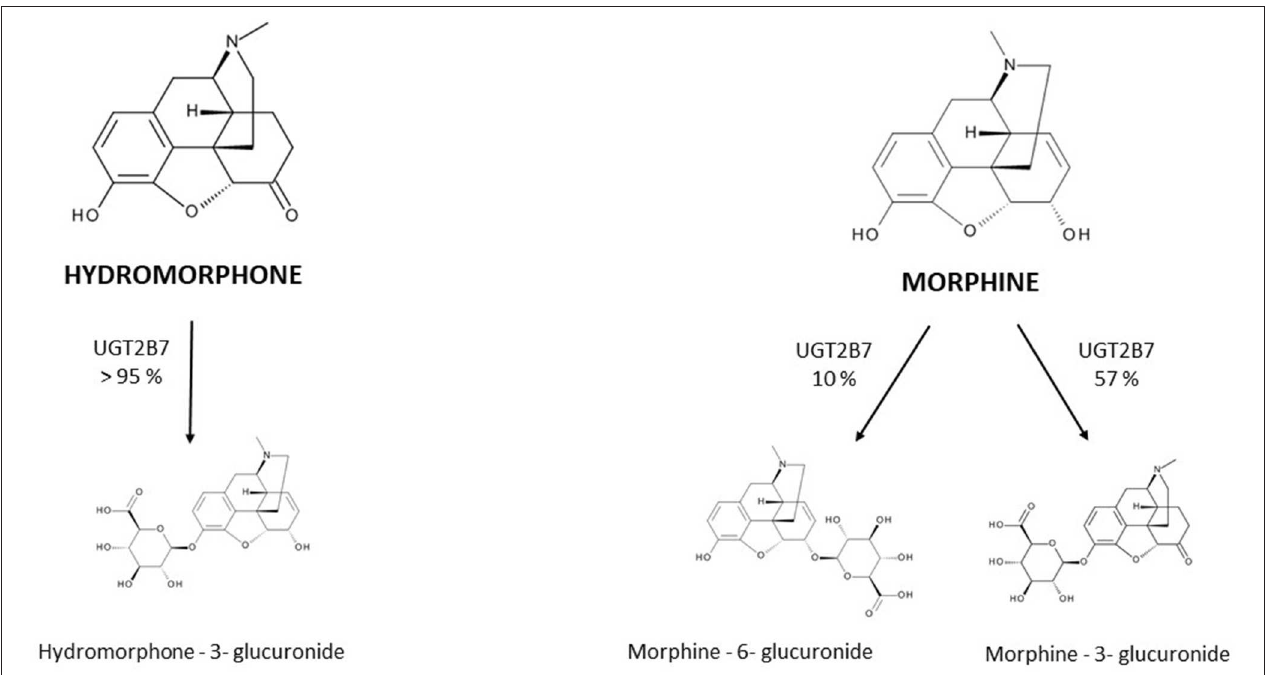
FIGURE 1 | Metabolism of hydromorphone and morphine into their main metabolites. UGT = uridine 5 ′ -diphospho-glucuronosyltransferase.